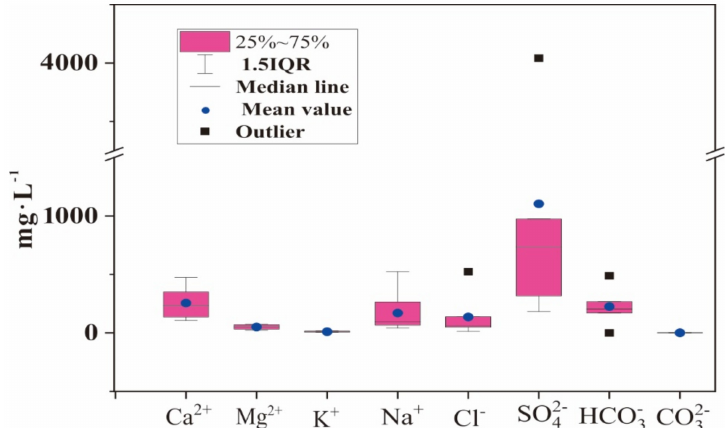
Figure 5. Box chart of ionic concentrations in the